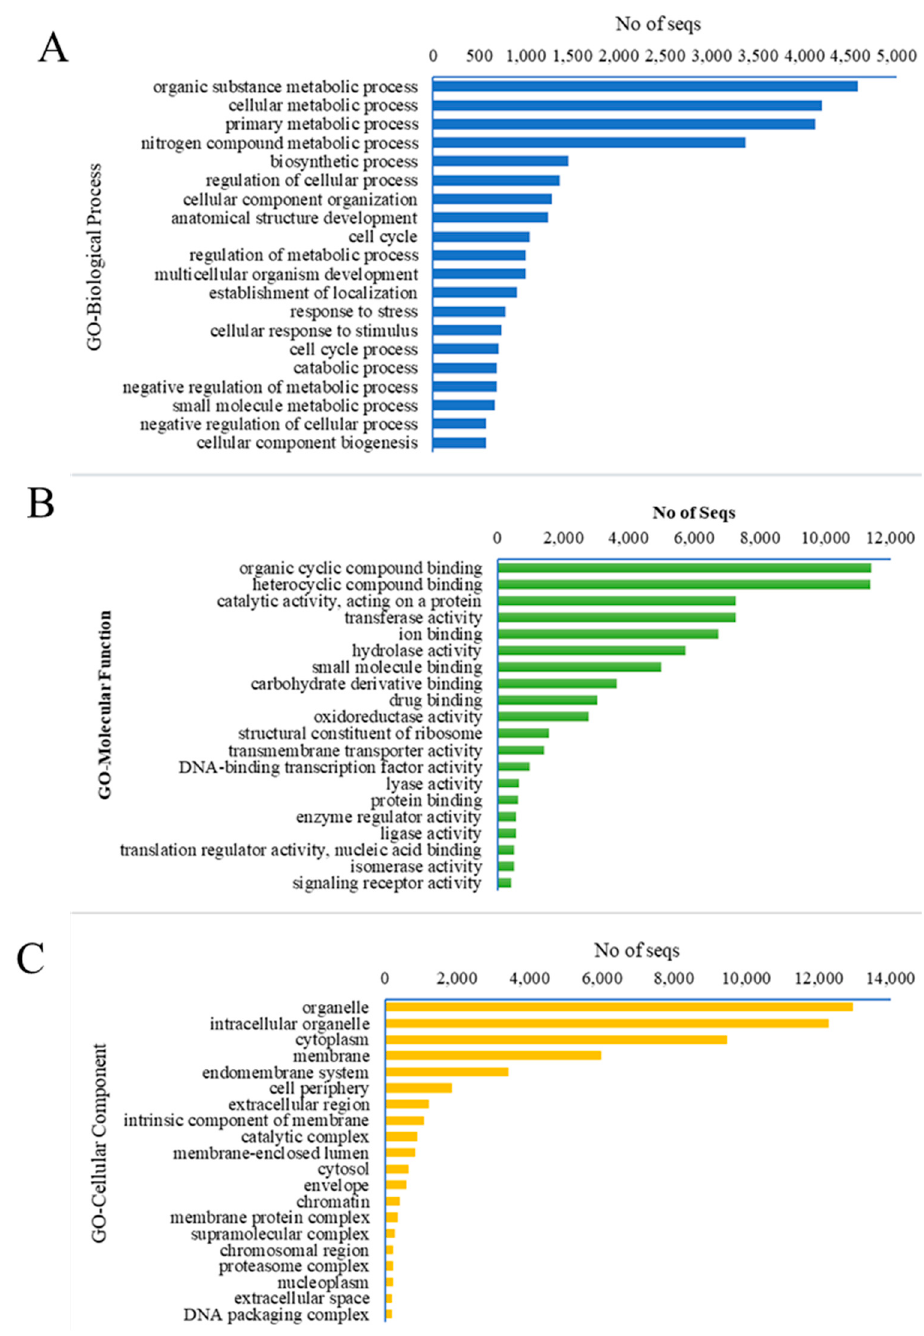
Figure 4. Histogram of gene ontology analysis of the number of transcripts annotated for C. caudatus. The classification was according to three main GO domains; ( A ) biological process, ( B ) molecular function, ( C ) cellular component.